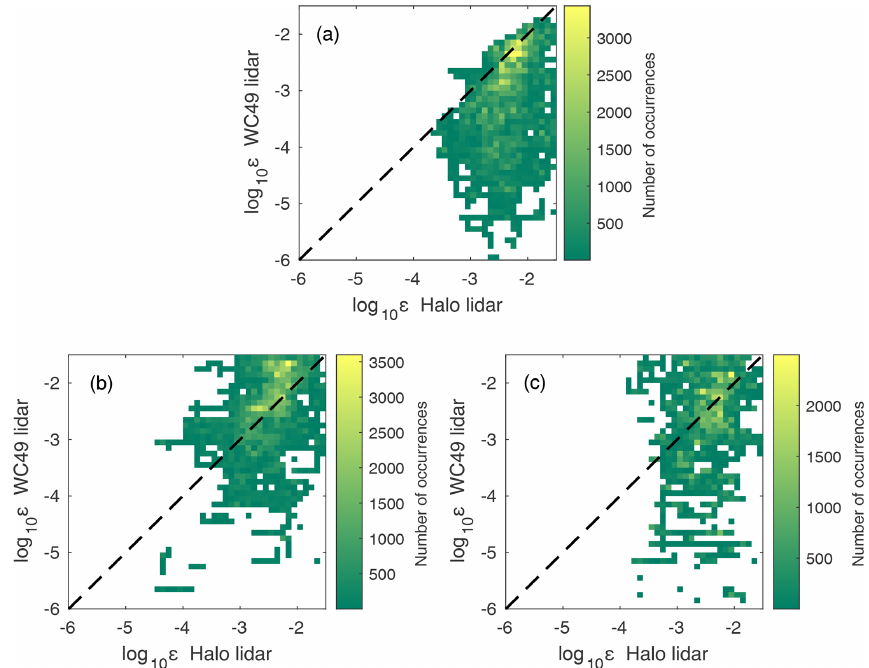
Figure 7. Heat map of log 10 ε showing scanning technique variability at the Moffat site for both lidars at 105m (a) , 135m (b) , and 160m (c) . The shading indicates the number of occurrences of each value of log 10 ε for each lidar. The values of turbulence dissipation rate are averaged over a 30min time period. The black dashed line shows a 1 : 1 relationship.